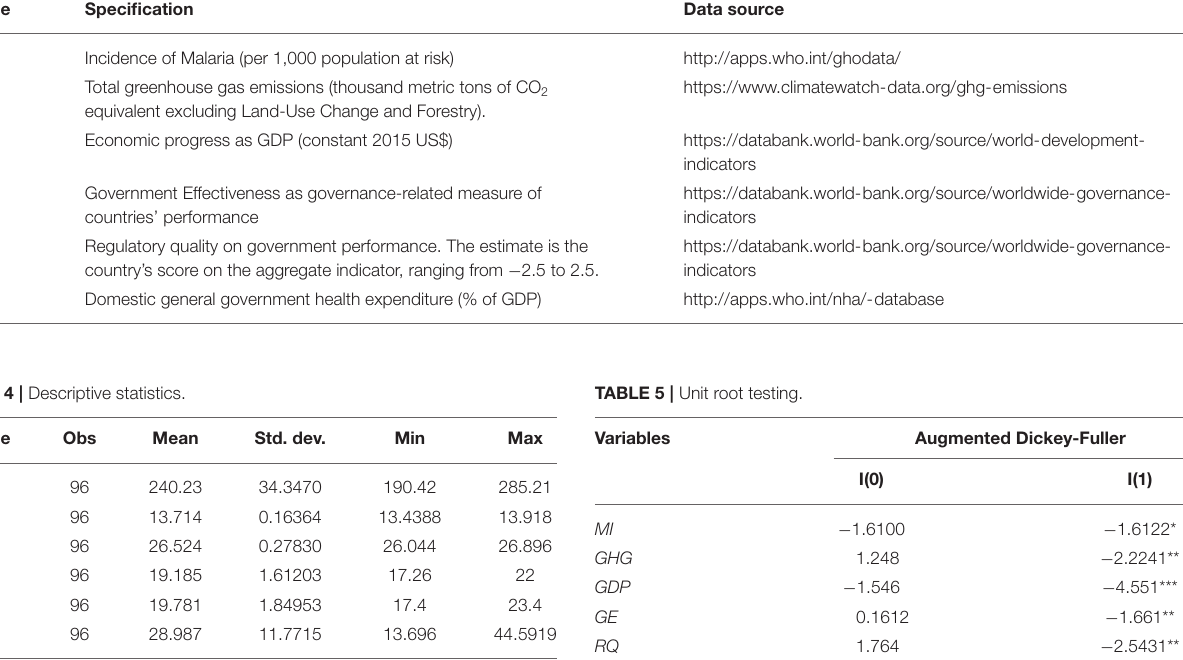
TABLE 3 | Variables specifications. Variable